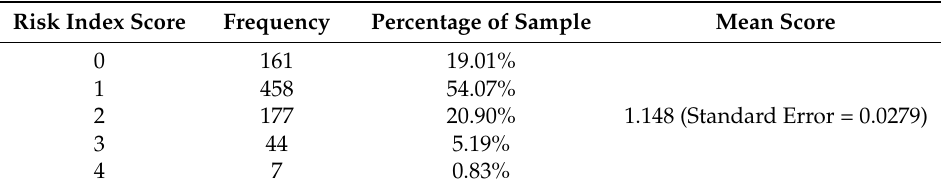
Table 6. Descriptive Statistics of Risk Index